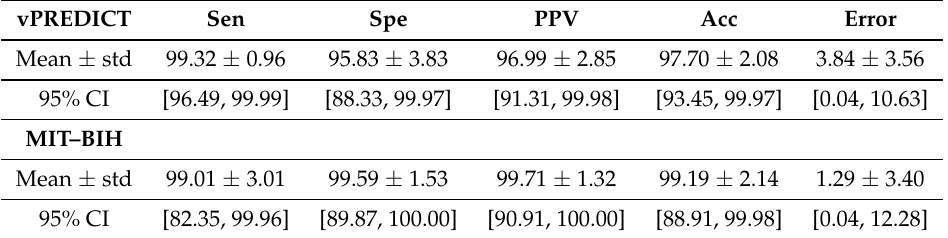
Table 5. R-wave results on 24-h Holter recordings from vPREDICT and MIT–BIH databases.